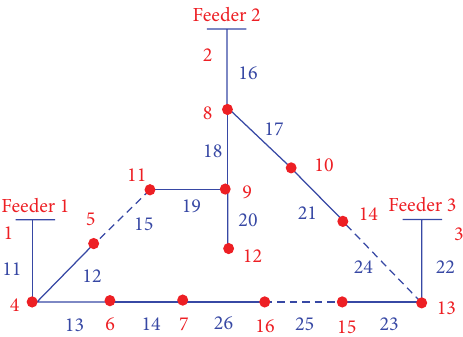
Figure 5: Distribution network after